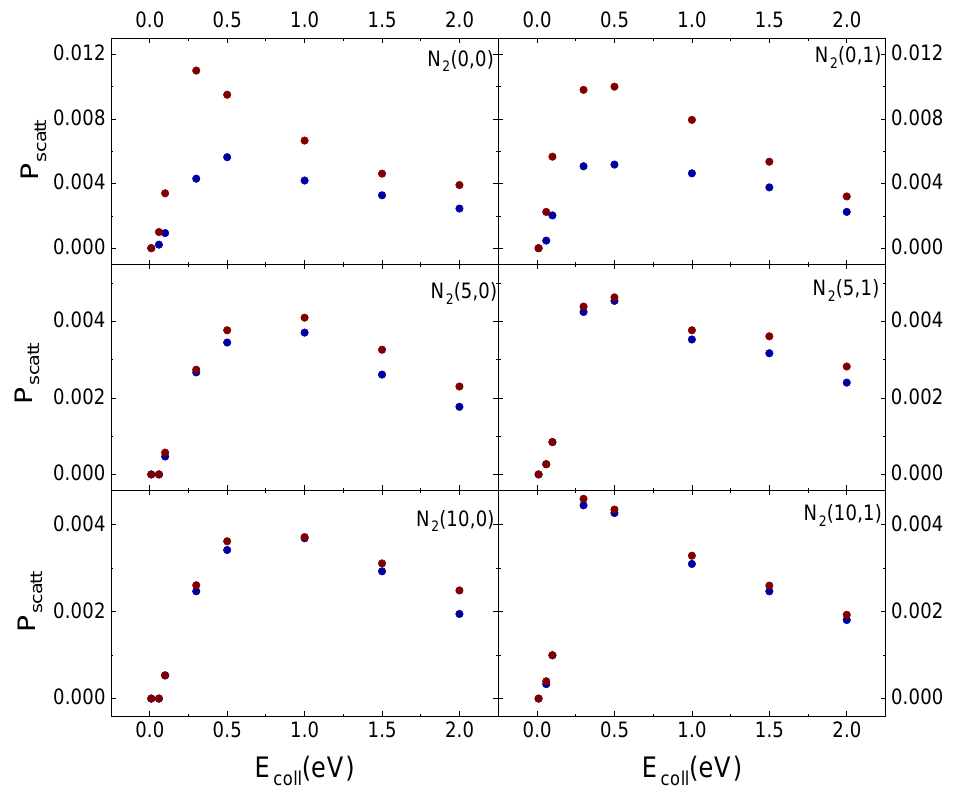
Figure 11. Probability (P scatt ) for inelastic scattering of N 2 (v i ,0) and N 2 (v i ,1) from cristobalite for T S = 100 K (blue solid dots) [29] and T S = 1000 K (red solid dots) as a function of the collision energy.